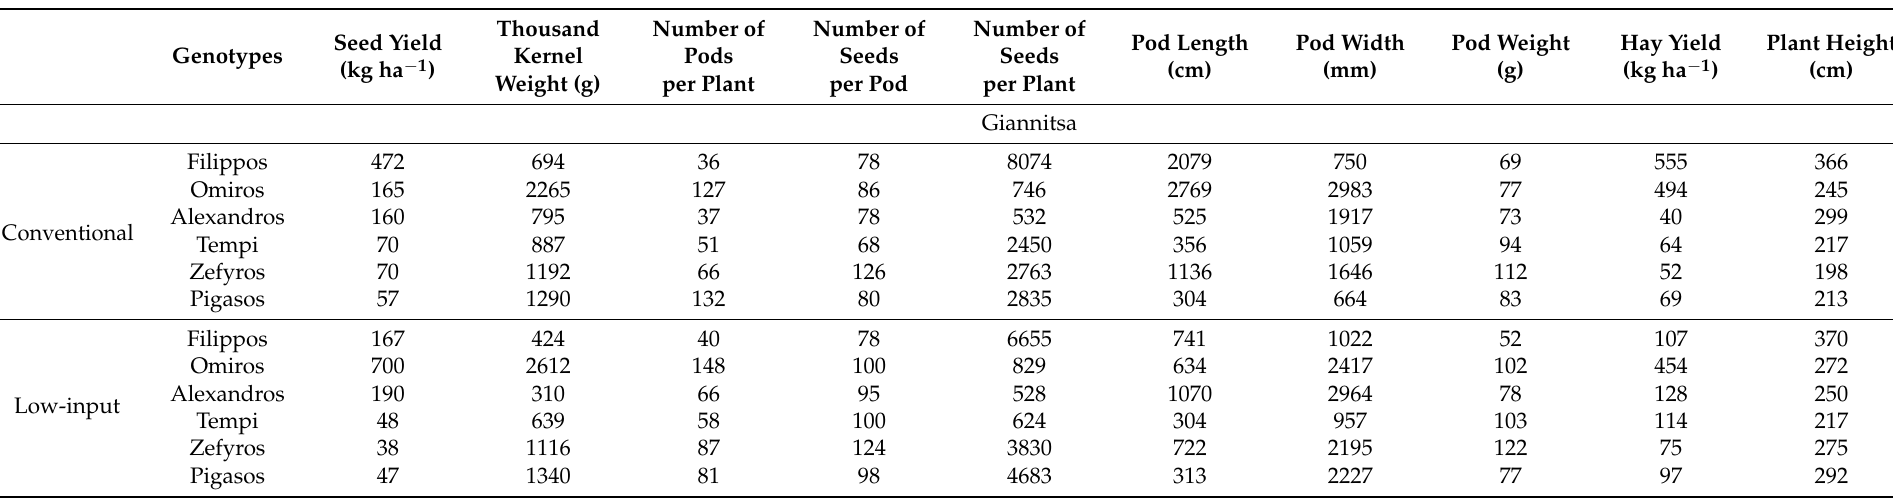
Table 3. Combined trait stability index across genotypes and environments for the two farming systems: seed yield (kg ha − 1 ), thousand kernel weight (g), number of pods per plant, number of seeds per pod, number of seeds per plant, pod length (cm), pod width (mm), (mean) pod weight (g), hay weight (kg ha − 1 ), plant height